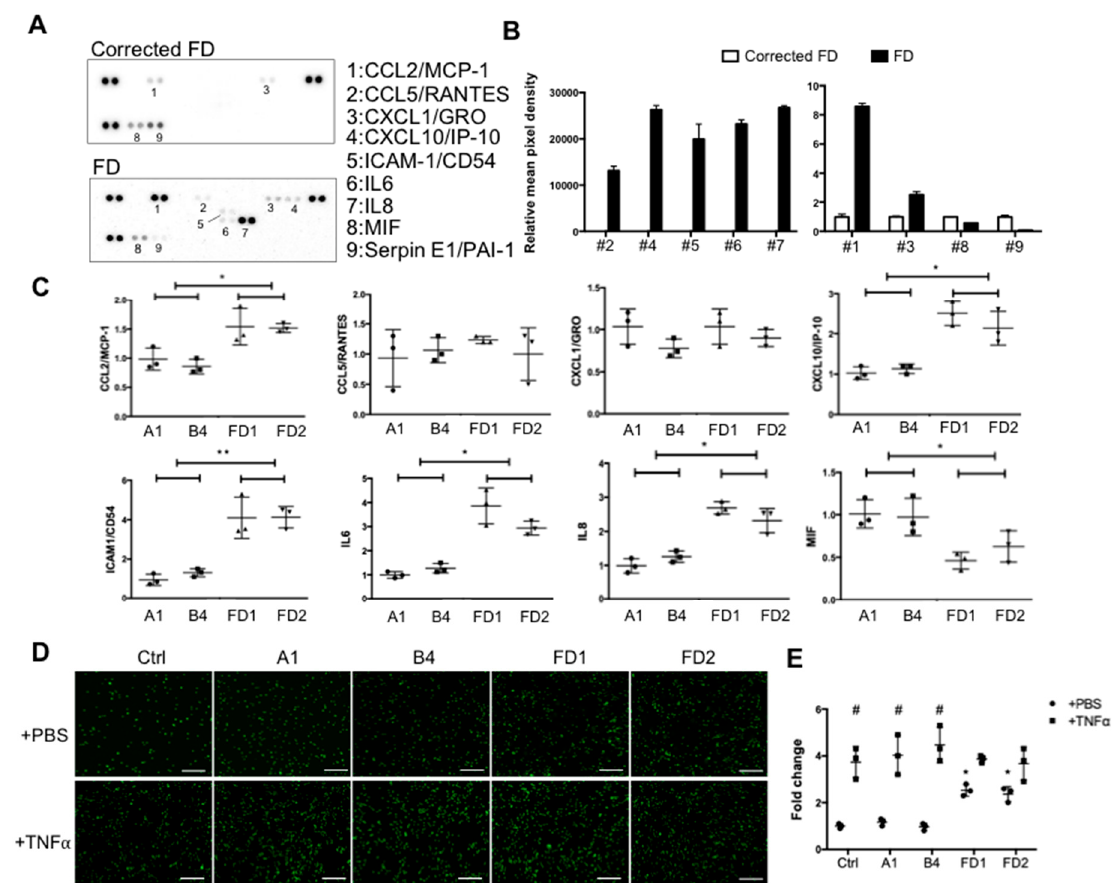
Figure 5. Cytokine releases and inflammatory status in corrected FD and FD-ECs. ( A ) Cytokine levels in conditioned media of corrected FD and FD-ECs were measured using a human cytokine Multi-Analyst ELISArray Kit and ( B ) normalized to the conditioned media of isogenic control. ( C ) Expression levels of pro-inflammatory genes validated by qRT-PCR ( n = 3 images from 3 biological replicates). ( D ) Representative images for monocyte (THP-1) adhesion in corrected FD and FD iPSC-ECs. HUVECs were used as a control (ctrl). ( E ) Quantification of THP-1 adhesion of experiments ( n = 3 images from 3 biological replicates). * Compared to corrected FD individually. # Compared to PBS in TNF α treatment. The error bars represent SD. One-way ANOVA was used for statistical analysis (* p < 0.05; # p < 0.05).